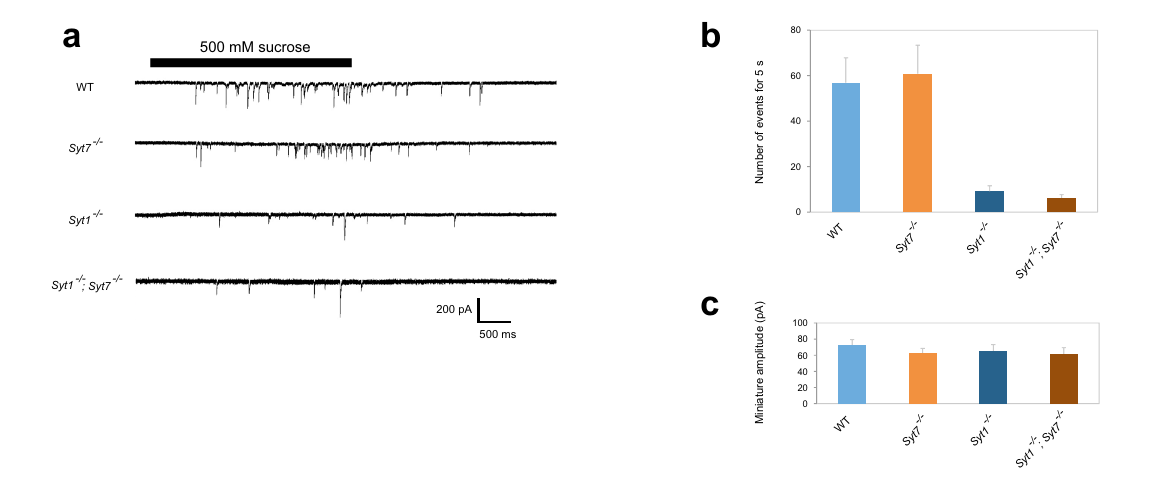
Figure 3. Hypertonic-induced miniature release. ( a ) Representative traces for each genotype. 500 mM sucrose was applied for 3 s (bar) in the absence of Ca 2+ . ( b ) Number of hypertonic-induced miniature synaptic currents recorded during 5 s after the beginning of application of 500 mM sucrose. Numbers of recorded cells: WT, 24; Syt7 −/− , 24; Syt1 −/− , 38; Syt1 −/− ; Syt7 −/− , 39. ( c ) Amplitude of miniature synaptic currents induced by hypertonic stimulation with 500 mM sucrose. Amplitudes recorded from a single muscle cell were averaged and the averages for each cell are shown. Number of recorded cells are the same as those in b. Error bars are